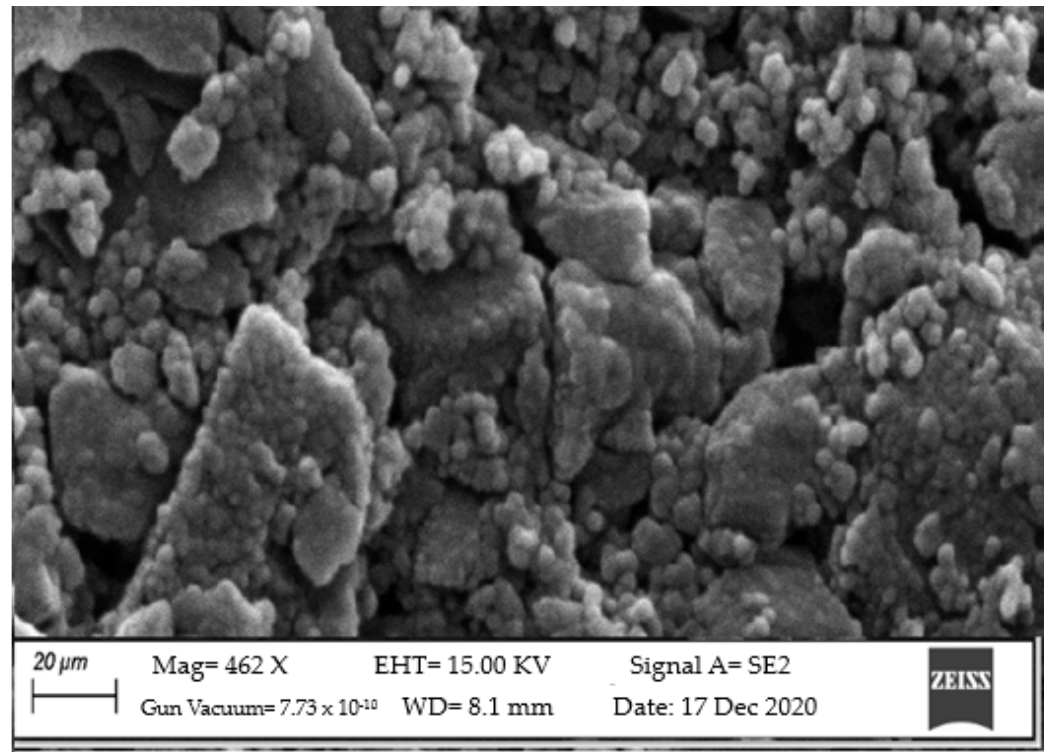
Figure 3. SEM of HTiO 2 @AC/SiO 2 composite for surface morphology. Mag = 462 X EHT = 15.00 KV Signal A = SE2 Gun Vacuum = 7.73 × 10 − 10 WD = 8.1 mm Date: 17 December 2020.